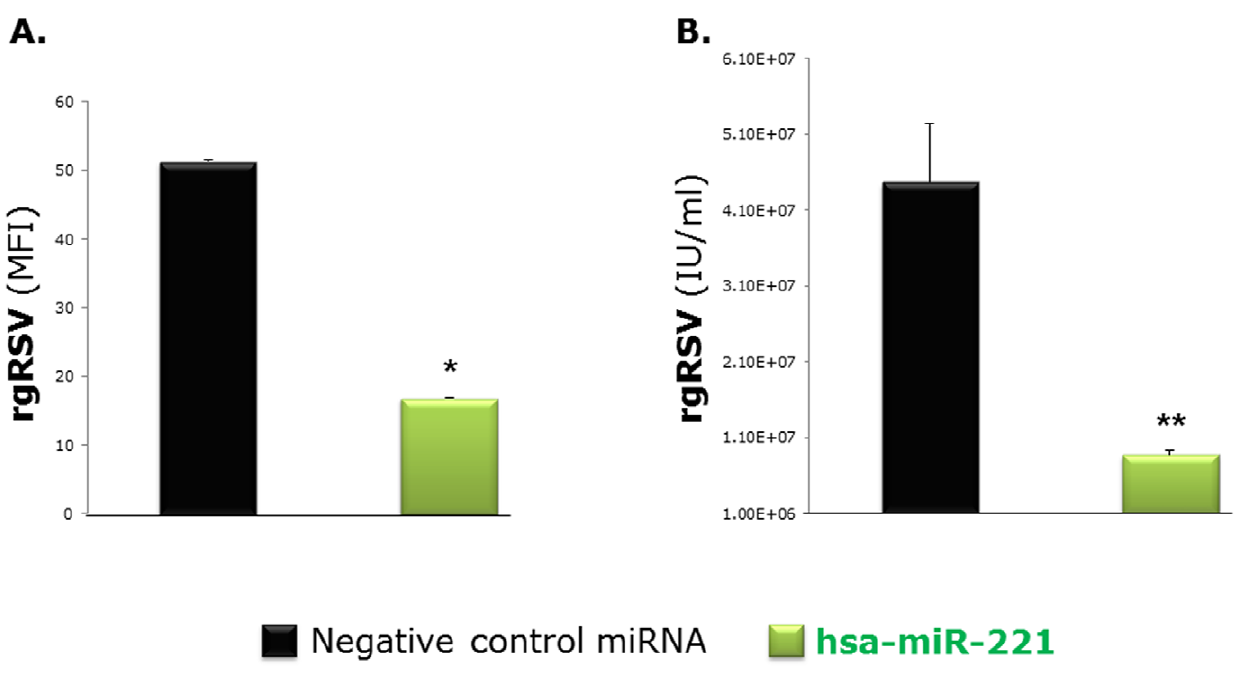
Figure 7. Anti-viral effect of miR-221. (A) FACS showed that hsa-miR-221 transfection reduces significantly the number of rgRSV-infected bronchial cells compared to control cells with normal hsa-miR-221 expression. Geometric mean fluorescent intensity (MFI) was averaged from the flow cytometry measurements obtained in 3 independent experiments. (B) Even stronger inhibition was measured in separate experiments by the titration of fluorescent virus infectious units per ml (IU/ml; n=6 per group). Data are expressed as the mean 6 SEM. **=p , 0.01 compared to cells transfected with the negative control miRNA.